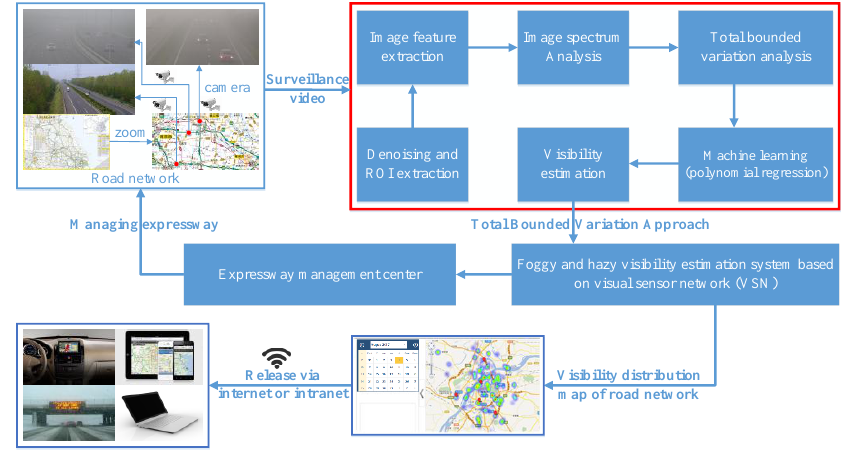
Figure 1. Practical application of total bounded variation approach.